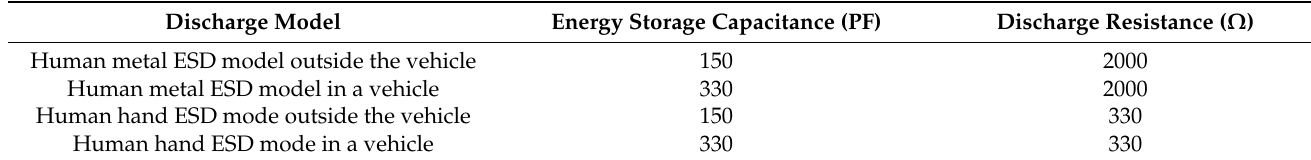
Figure 4. Simplified circuit diagram of the electrostatic generator. Table 2. Relationships among discharge model, energy storage capacitor, and discharge resistance.